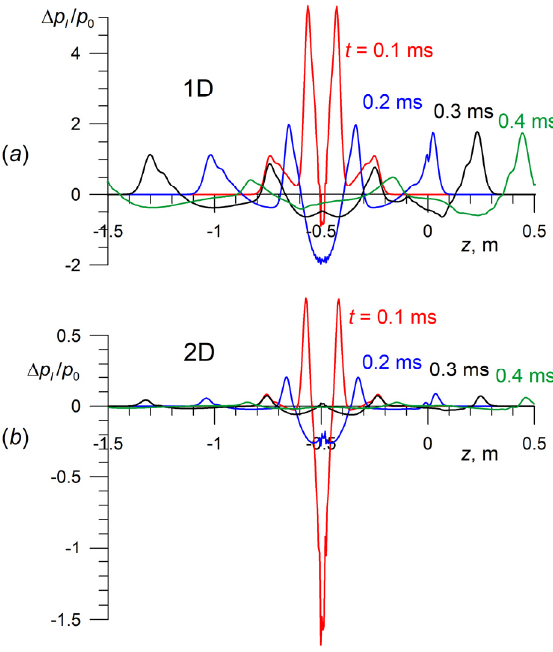
Figure 6. The average pressure profiles ∆ p l / p 0 in a liquid when a perturbation propagates from a source and passes/reflects through the boundary of the porous media and fractured-porous media for several time points in one-dimensional ( a ) and two-dimensional ( b ) cases, x = 100 cm. Note that in a fractured porous medium, the wave contains three modes [10].